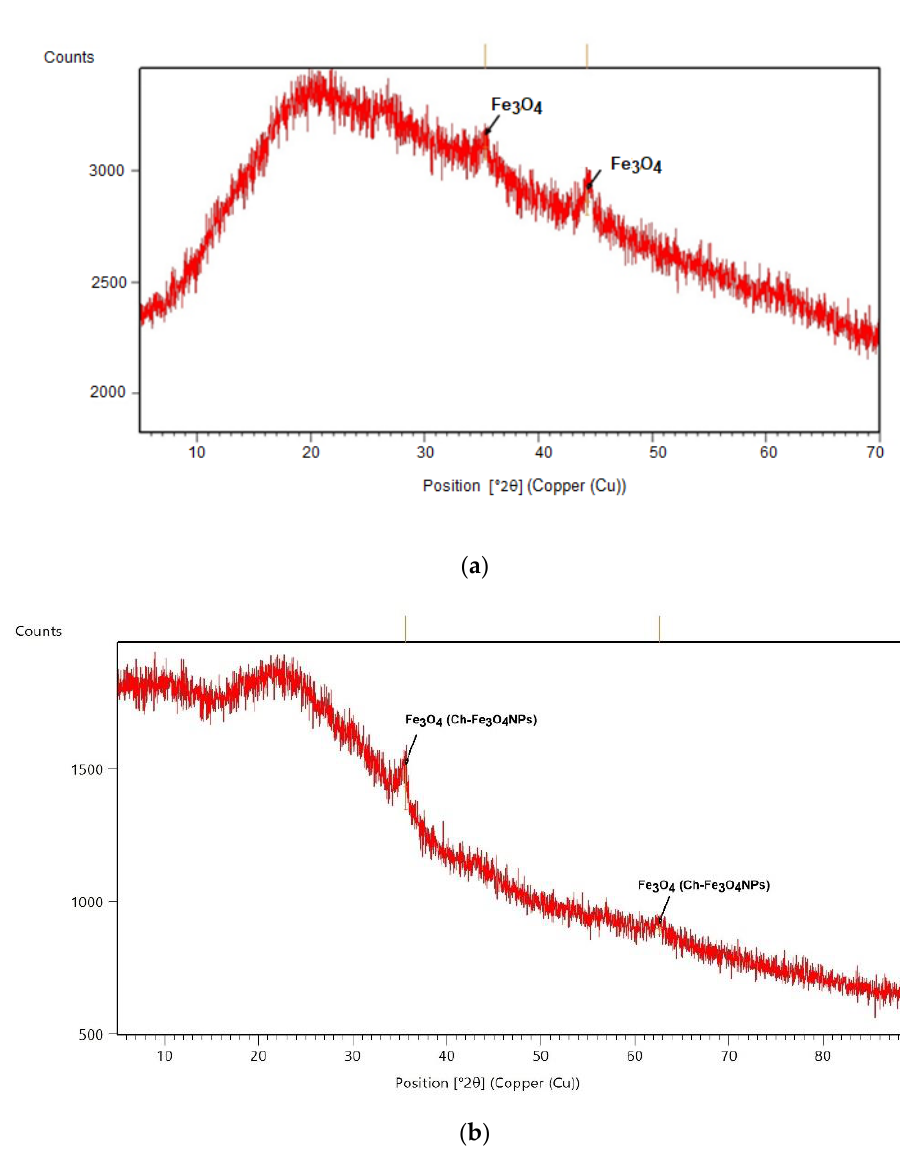
Figure 2. X-ray diffractograms: Fe 3 O 4 NPs ( a ) and Ch- Fe 3 O 4 NPs ( b